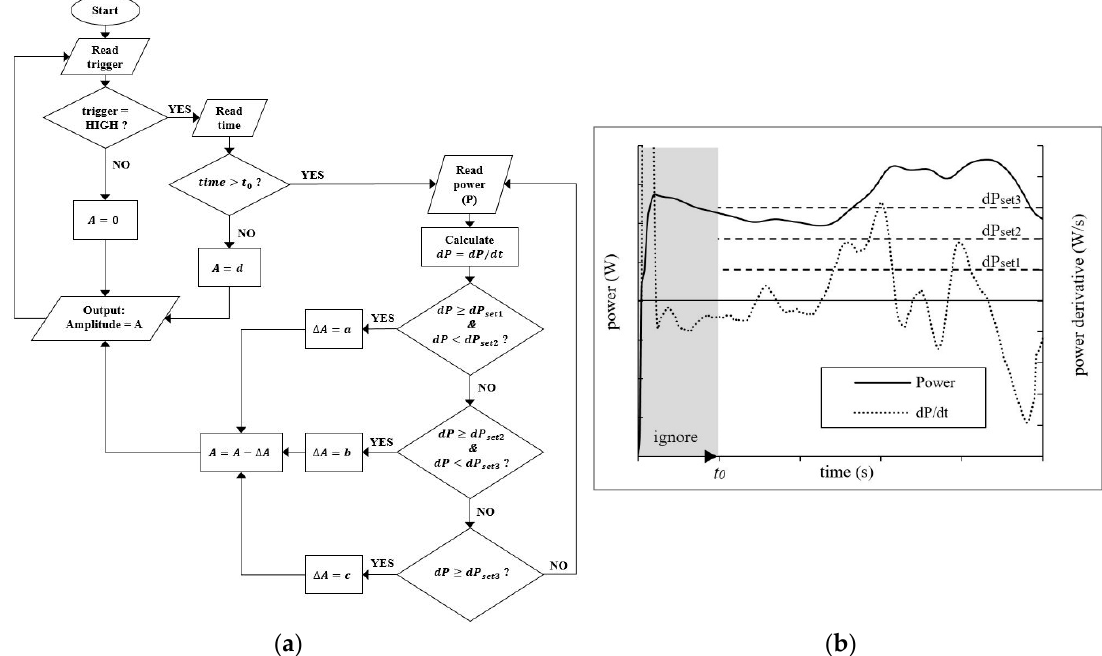
Figure 4. ( a ) The algorithm of the control program in the microcontroller. ( b ) Schematic illustration of the algorithm.